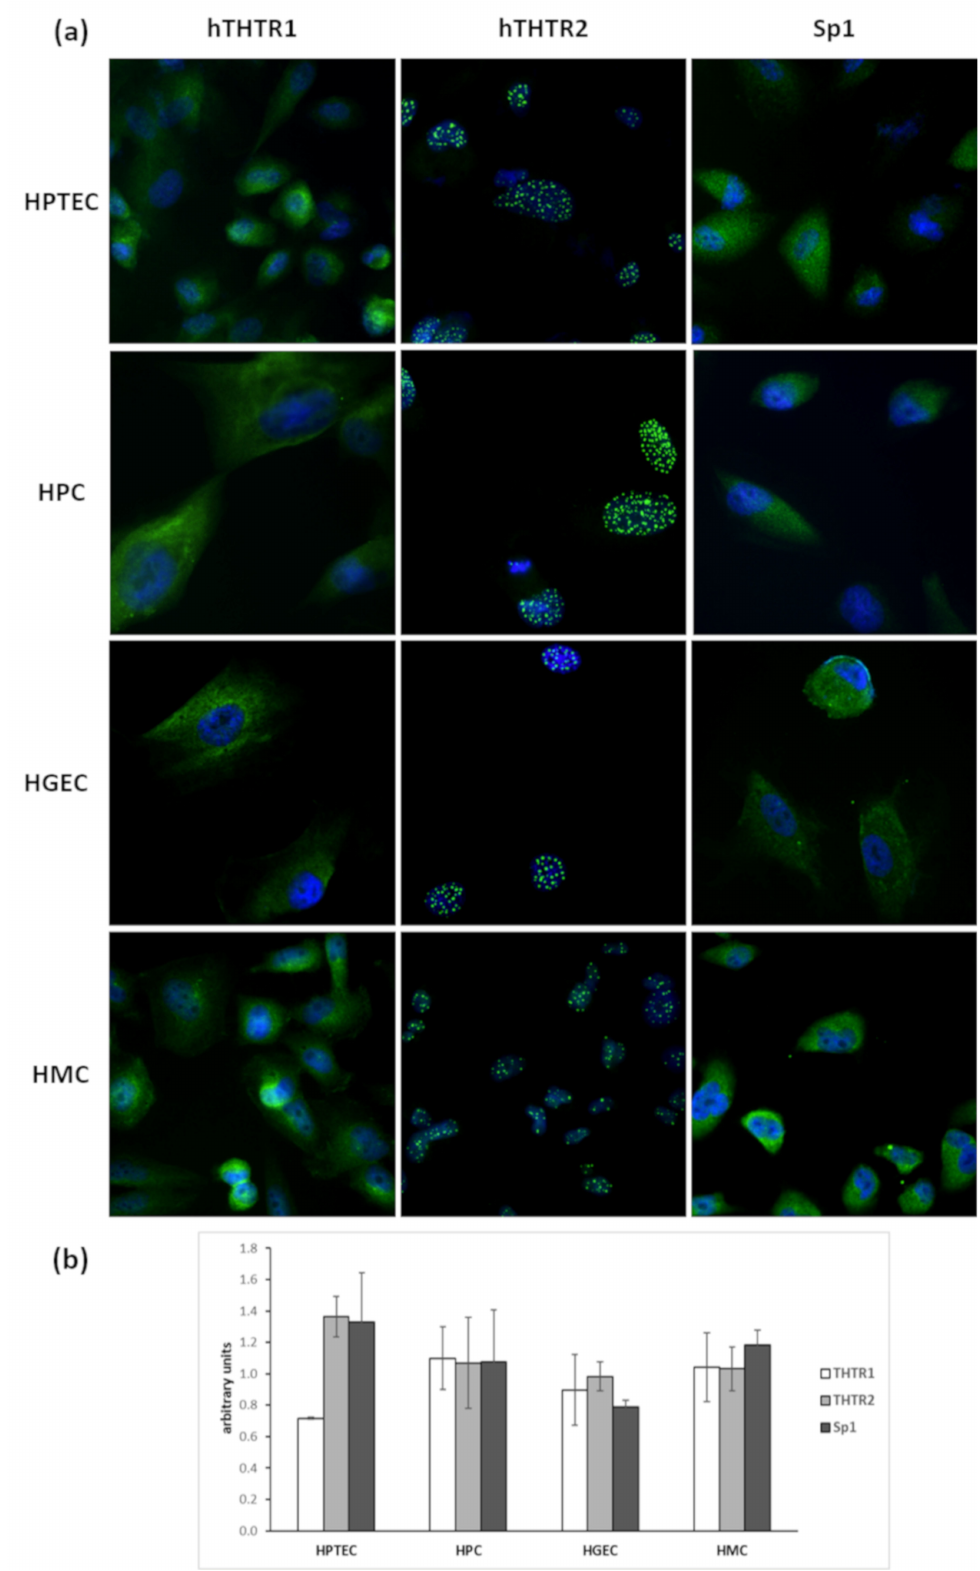
Figure 1. Localization and expression of thiamine transporters and Sp1 inside renal glomerular cells in physiological conditions. ( a ) Immunofluorescence with Ab anti-THTR1, anti-THTR2, and anti-Sp1 in HPTEC, HPC, HGEC, and HMC (green). Nuclei are counterstained with DAPI (blue). Magnification 400 × . ( b ) Relative expression of THTR-1, THTR2, and Sp1 in the 4 cell types. Mean of 5 experiments ±